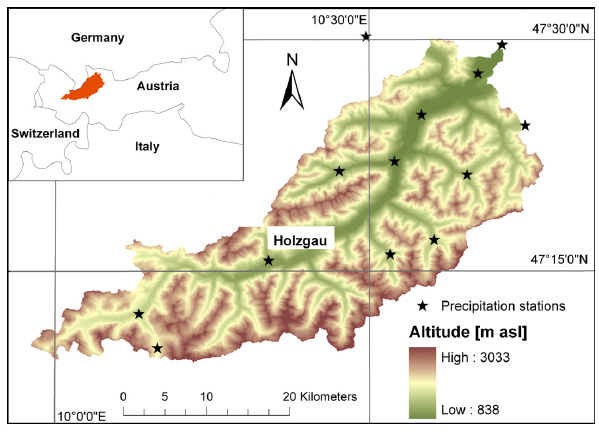
Fig. 1. Study area with rain